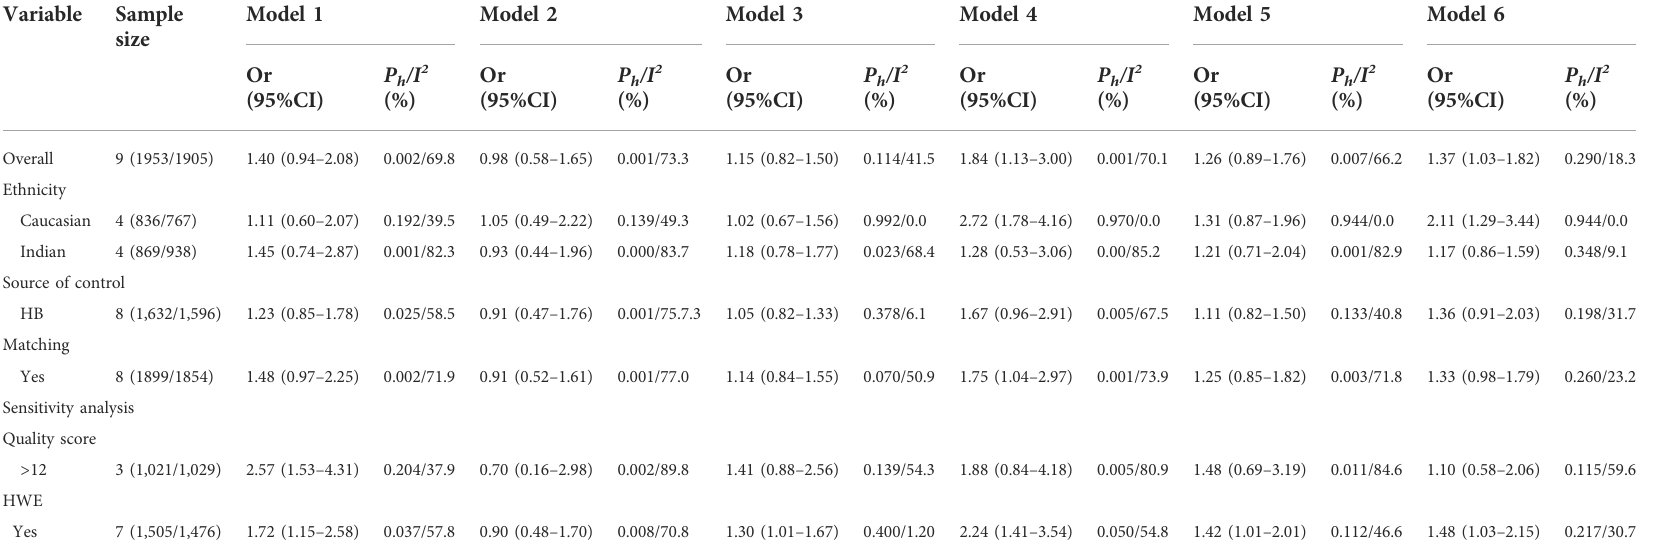
TABLE 5 Meta-analysis of the combined effects of GSTM1 present/null and GSTP1 IIe105Val on T2DM